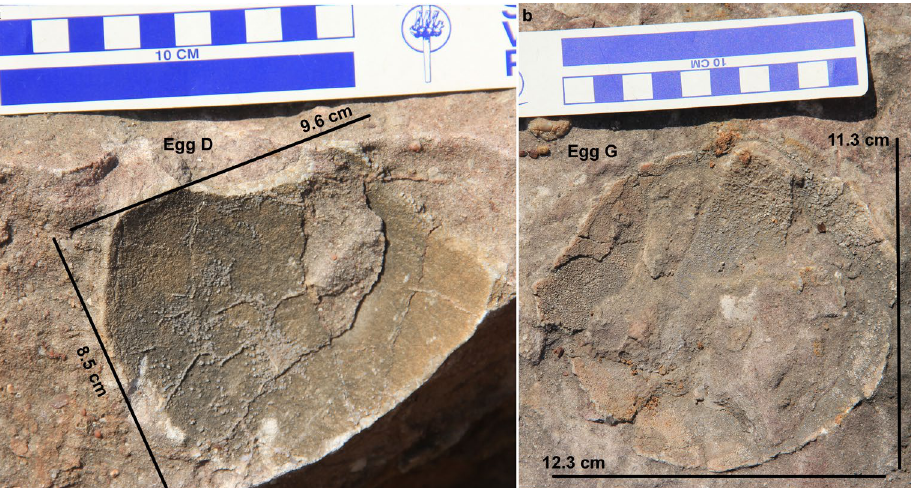
Figure 7. Field photographs of eggs from nest number P7. ( a ) Partially preserved bottom surface of an egg. ( b ) Circular bottom surface of an egg with encrusted eggshells.